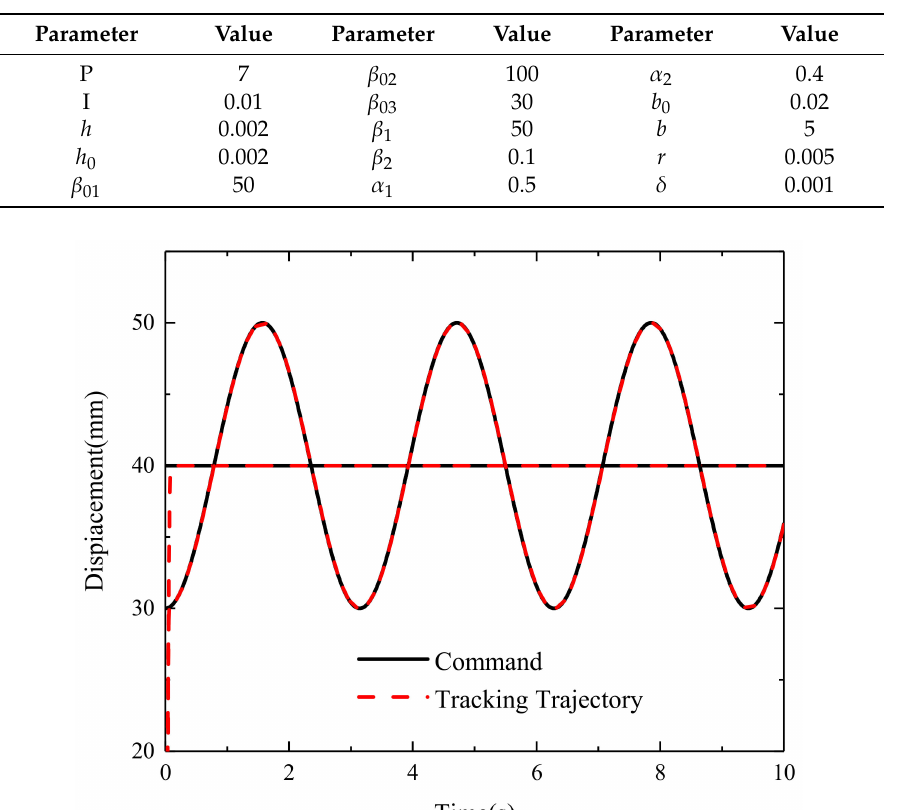
Table 2. The controller’s parameters.